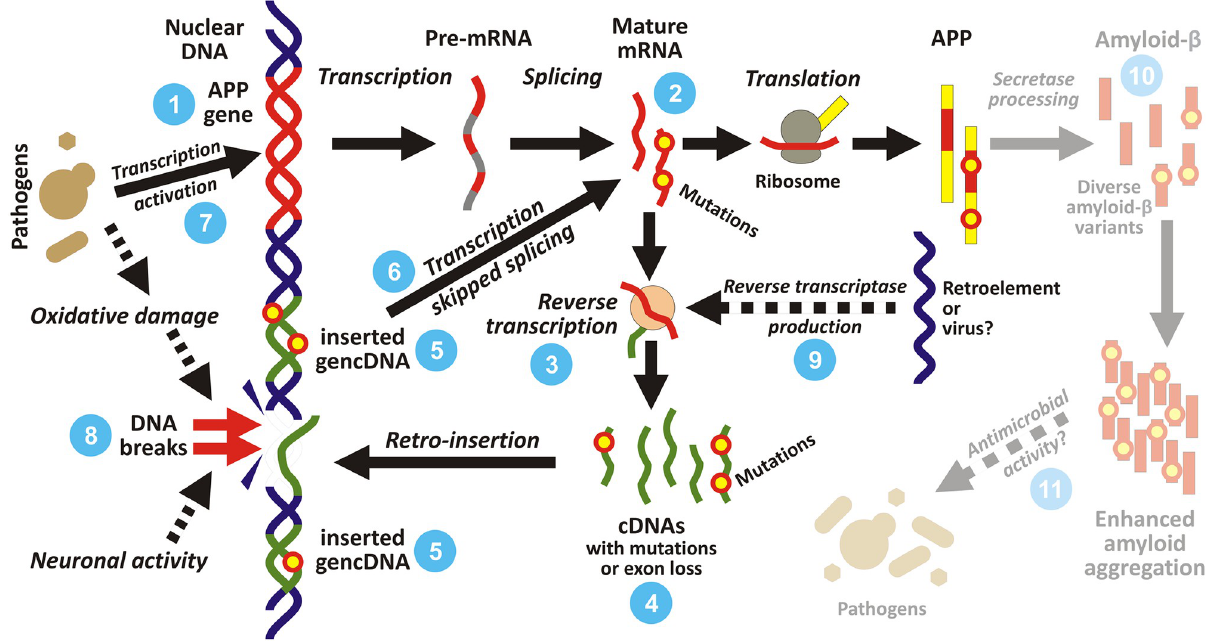
Fig 3. Somatic APP gene recombination. In human neurons, additional copies of the APP gene are created by the process of somatic recombination. The original APP gene ( 1 ) is undergoing standard transcription and splicing. Mature APP mRNAs ( 2 ) can undergo the process of reverse transcription ( 3 ) to complementary DNAs (cDNAs; 4 ), which can be retro-inserted into genomic DNA as genome-inserted complementary DNAs (gencDNAs; 5 ). The resulting additional copies of APP gene lack introns and often bear point mutations or exon deletions as both regular and reverse transcription are error prone, but can still be transcribed and translated ( 6 ). Moreover, the resulting mRNAs may undergo repeated cycles of retro-insertion, leading to accumulation of errors. We propose that cerebral infection provides some of the necessary ingredients for this mechanism, namely activation of APP expression ( 7 ), oxidative damage leading to DNA breaks ( 8 ), and a source of reverse transcriptase ( 9 ). Enhanced APP production by gene multiplication, and even the production of aggregation-prone mutant forms of amyloid beta ( 10 ) might act as an antimicrobial defensive mechanism ( 11 ). However, it is also harmful to the tissue itself, and as the mutant gencDNA insertion is irreversible, it may easily open the door to progressive neurodegeneration. APP, amyloid precursor protein; gencDNA, genome-inserted complementary DNA.